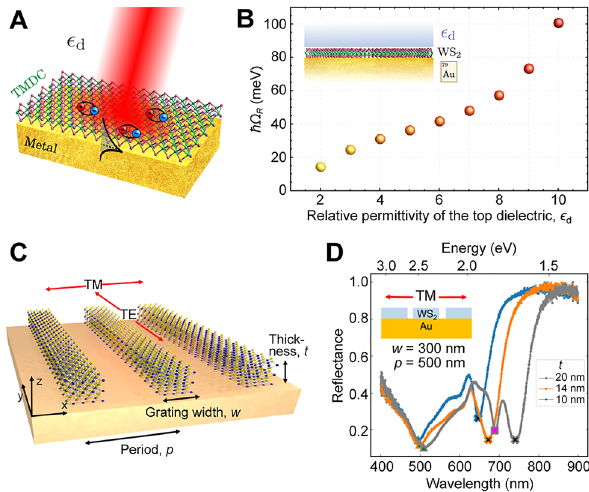
Figure 11: Hybridization of exciton-polaritons and metal plasmons. (A) Plasmon-exciton coupling in the dielectric/TMDC/metal system. (B) Rabi splitting energy (in meV) as a function of the dielectric constantofthetopinsulatorindielectric/WS 2 /Austructures.(A)and (B) Adapted with permission from [80]. Copyright 2018, American Physical Society. (C) Schematic of a multi-layer WS 2 grating struc-